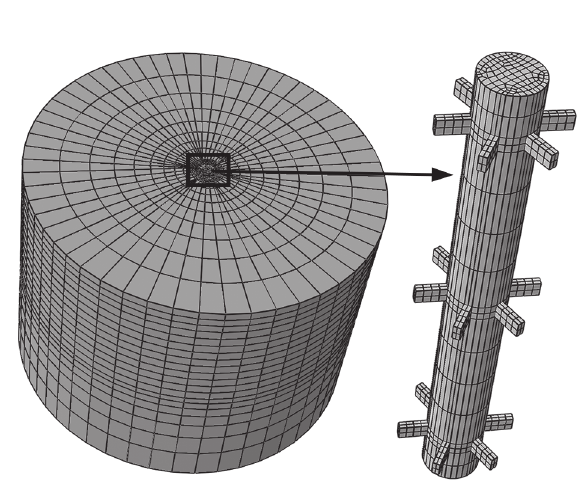
Figure 3: Finite element